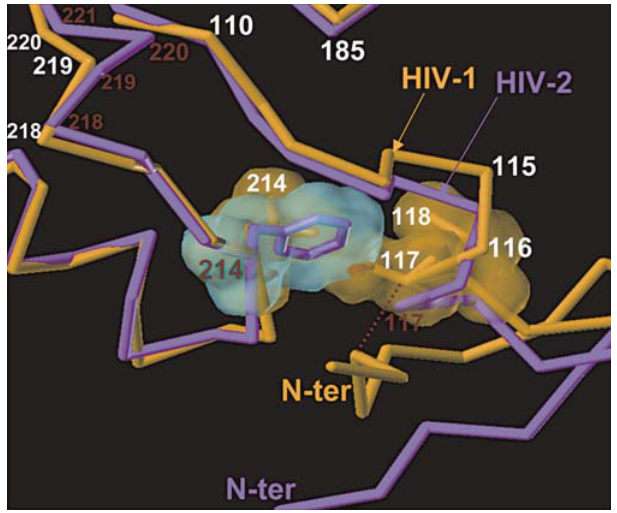
Figure 6. A Comparison of the Structure of an HIV-1 RT/DNA Complex with the Structure of Unliganded HIV-2 RT In the HIV-1 RT complex (PDB code 1N6Q), shown in yellow, the 3 9 end of the primer is in the N site, unliganded HIV-2 RT (PDB code 1MU2) is shown in magenta. The residues used for the superposition were 107 9 112 and 155 9 215. The Van der Waal radii for the atoms in the amino acid residues at positions 117 and 214 are shown as spheres: yellow for HIV-1 RT and blue for HIV-2 RT. The superposition highlights two major differences between the two enzymes: a) the interaction between the N terminus and residue Ser117 of p66 in HIV-1 RT (red dotted line) is absent in HIV-2 RT because in HIV-2 RT the N terminus has moved away from residue 117 (cyan dotted line); b) in HIV-1 RT, Ser117 interacts with Leu214 1 RT in a way that differs from the interaction of Ser117 and the bulkier Phe214 in HIV-2 RT. DOI: